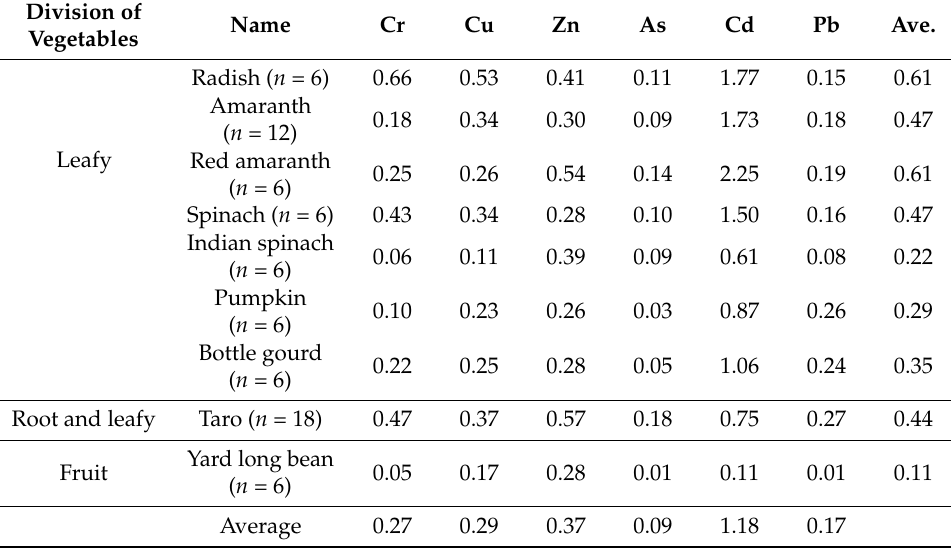
Table 4. Mean bioconcentration factor (BCF) of heavy metals for respective